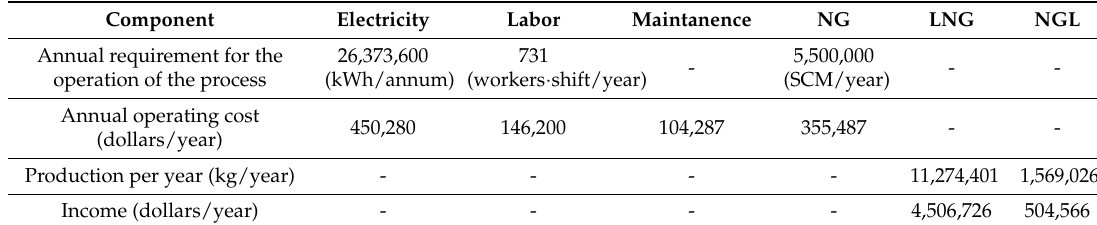
Table 9. Costs and